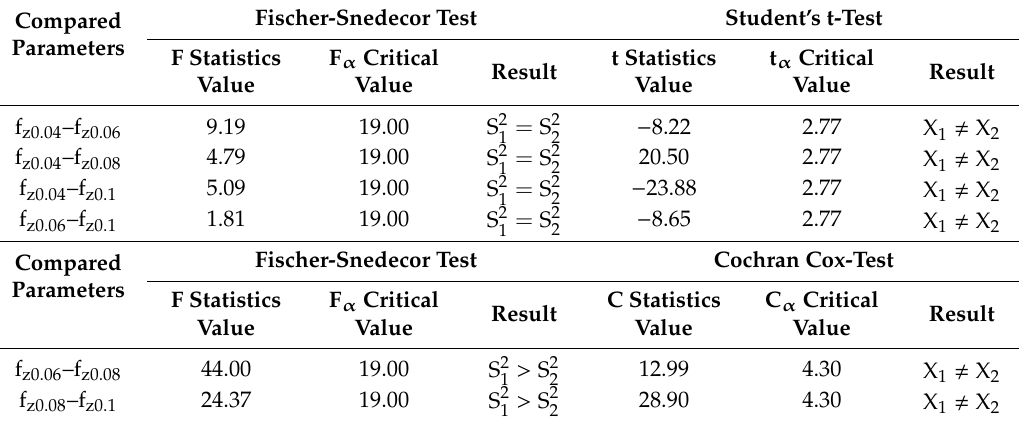
Table 10. Results of statistical analysis for f z variable during milling from composite layer (CFRP / Al) [28].